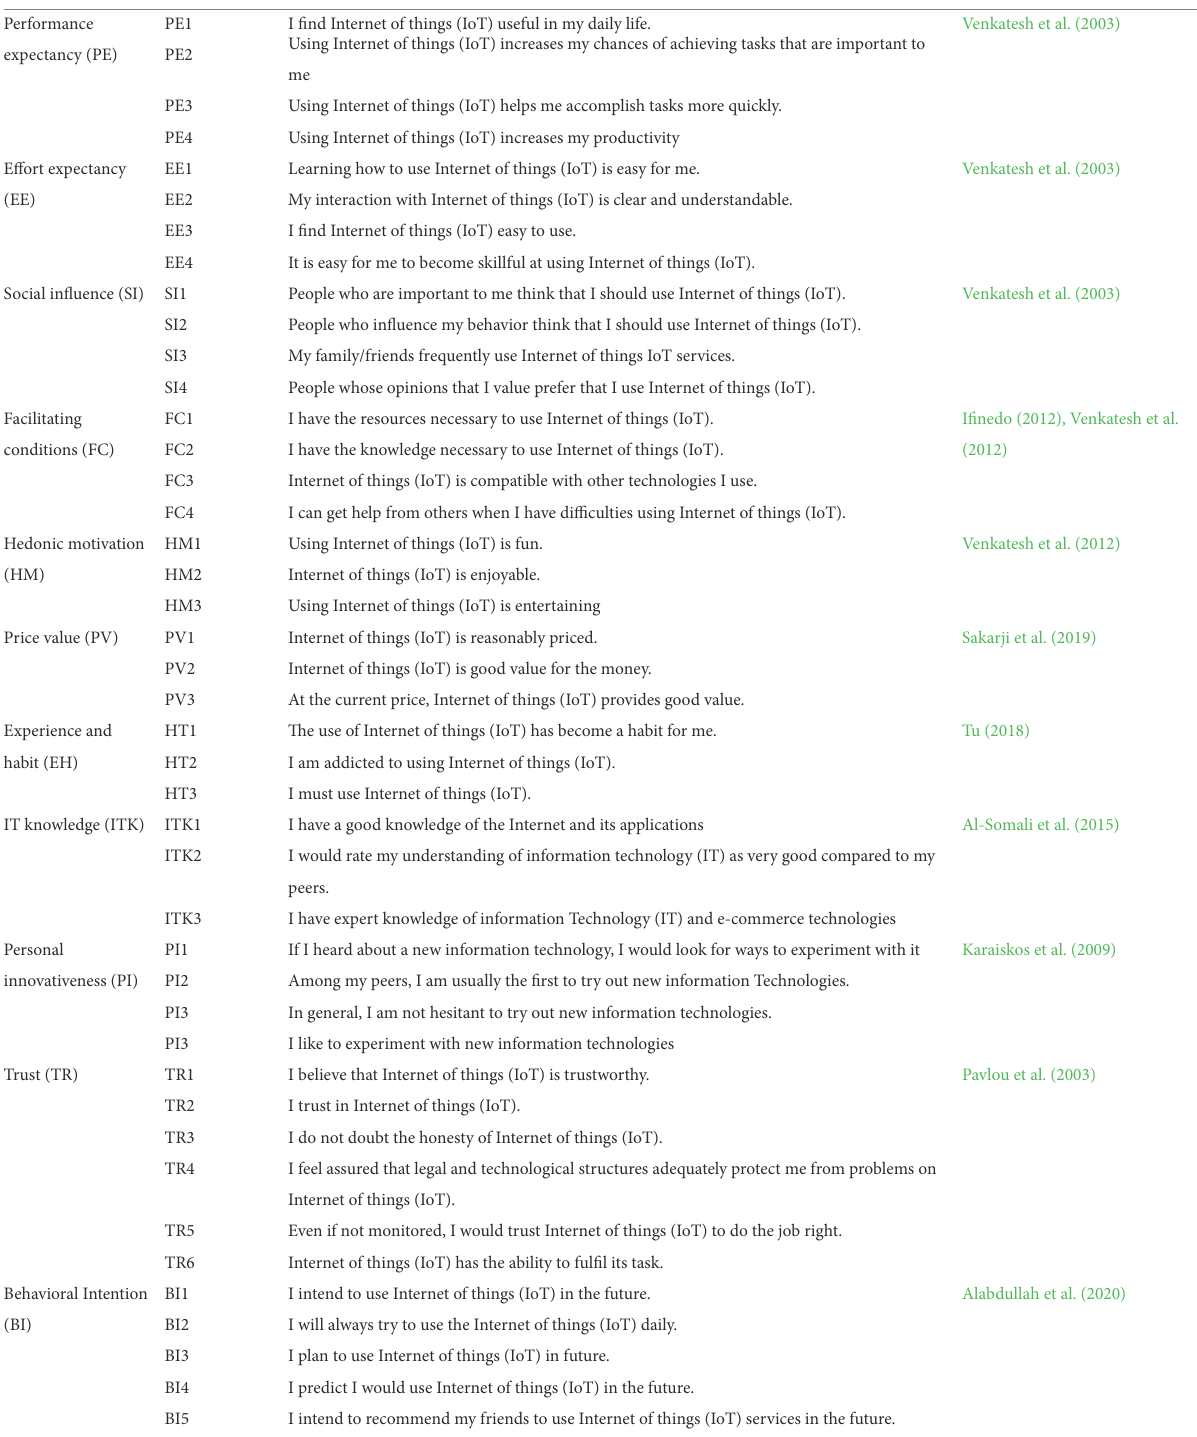
TABLE 1 Summary of construct with measurement items. Construct Corresponding items Items